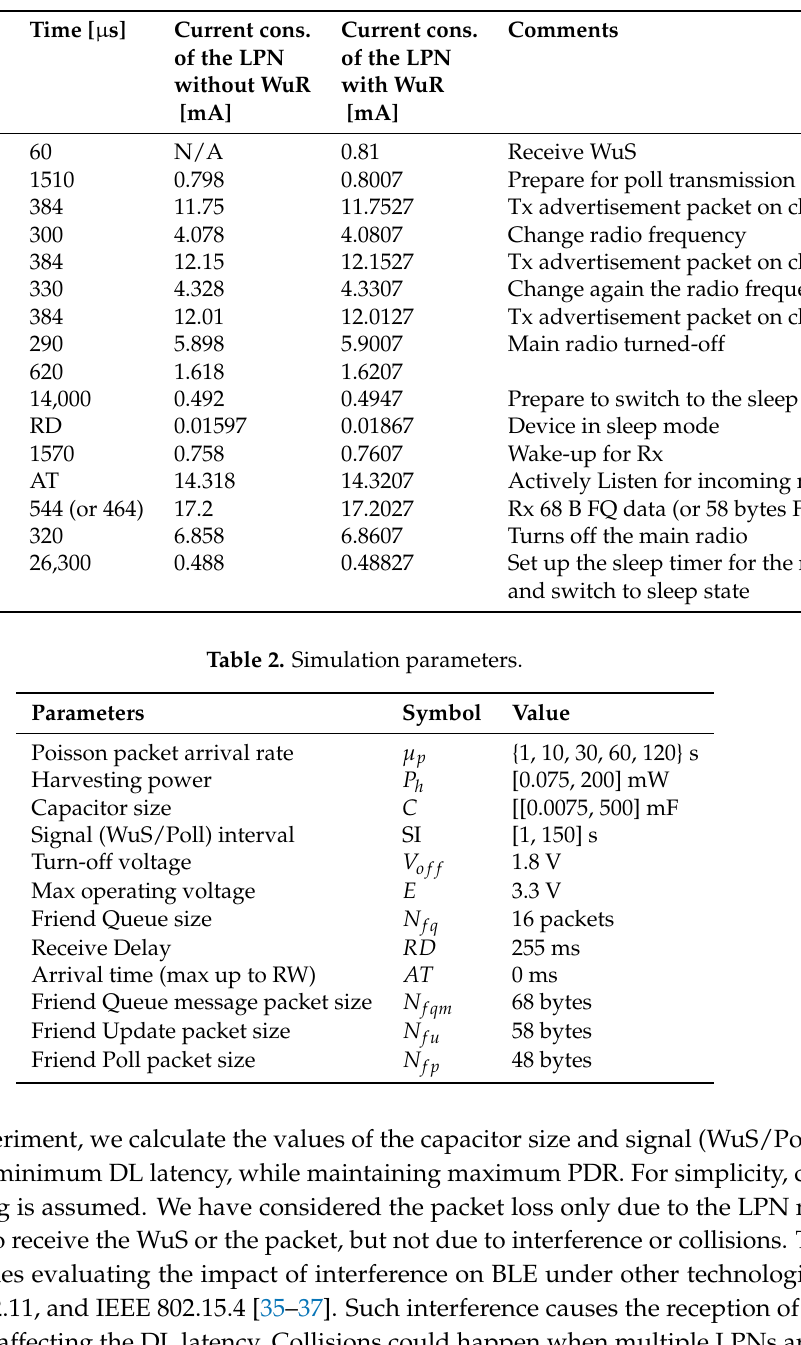
Table 1. Event sequence for a poll request and response of an LPN [32,33].